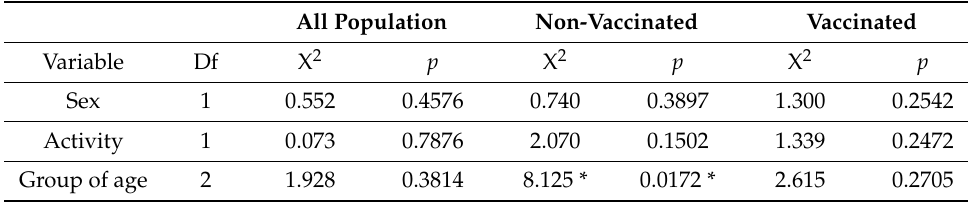
Table 2. The difference for EHV-1 antibody values by the ELISA type-specific based on sex, activity, and age group of the horses included in the study.